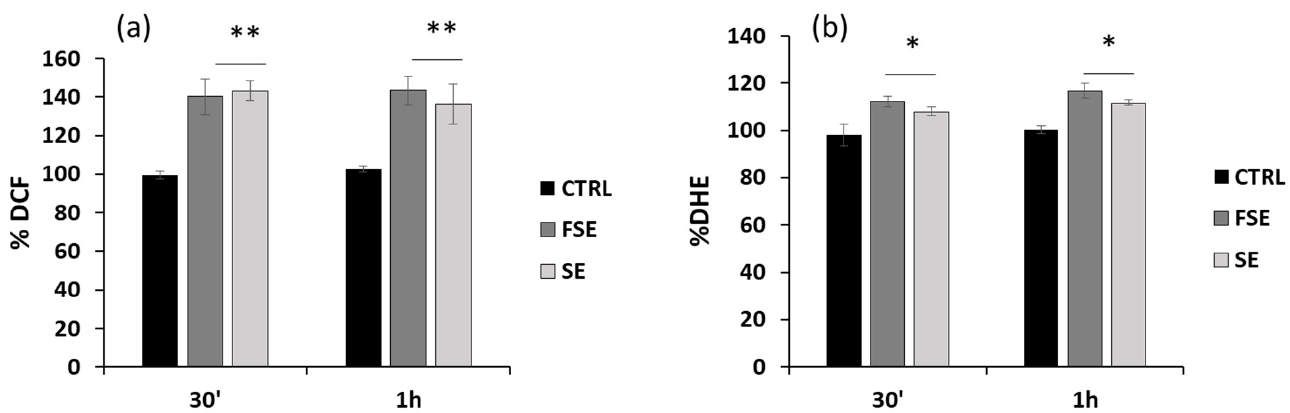
Figure 6. Pro-oxidant effect of FSE in HL-60 cells. Cells were treated with 50 µ M eqGA of FSE and SE at the indicated time and intracellular ( a ) ROS and ( b ) superoxide were measured as DCF and DHE fluorescence, respectively. Bar graphs represent means of three separate experiments. ± SD Symbols indicate significance: p < 0.05 (*) and p < 0.005 (**) respect to CTRL.